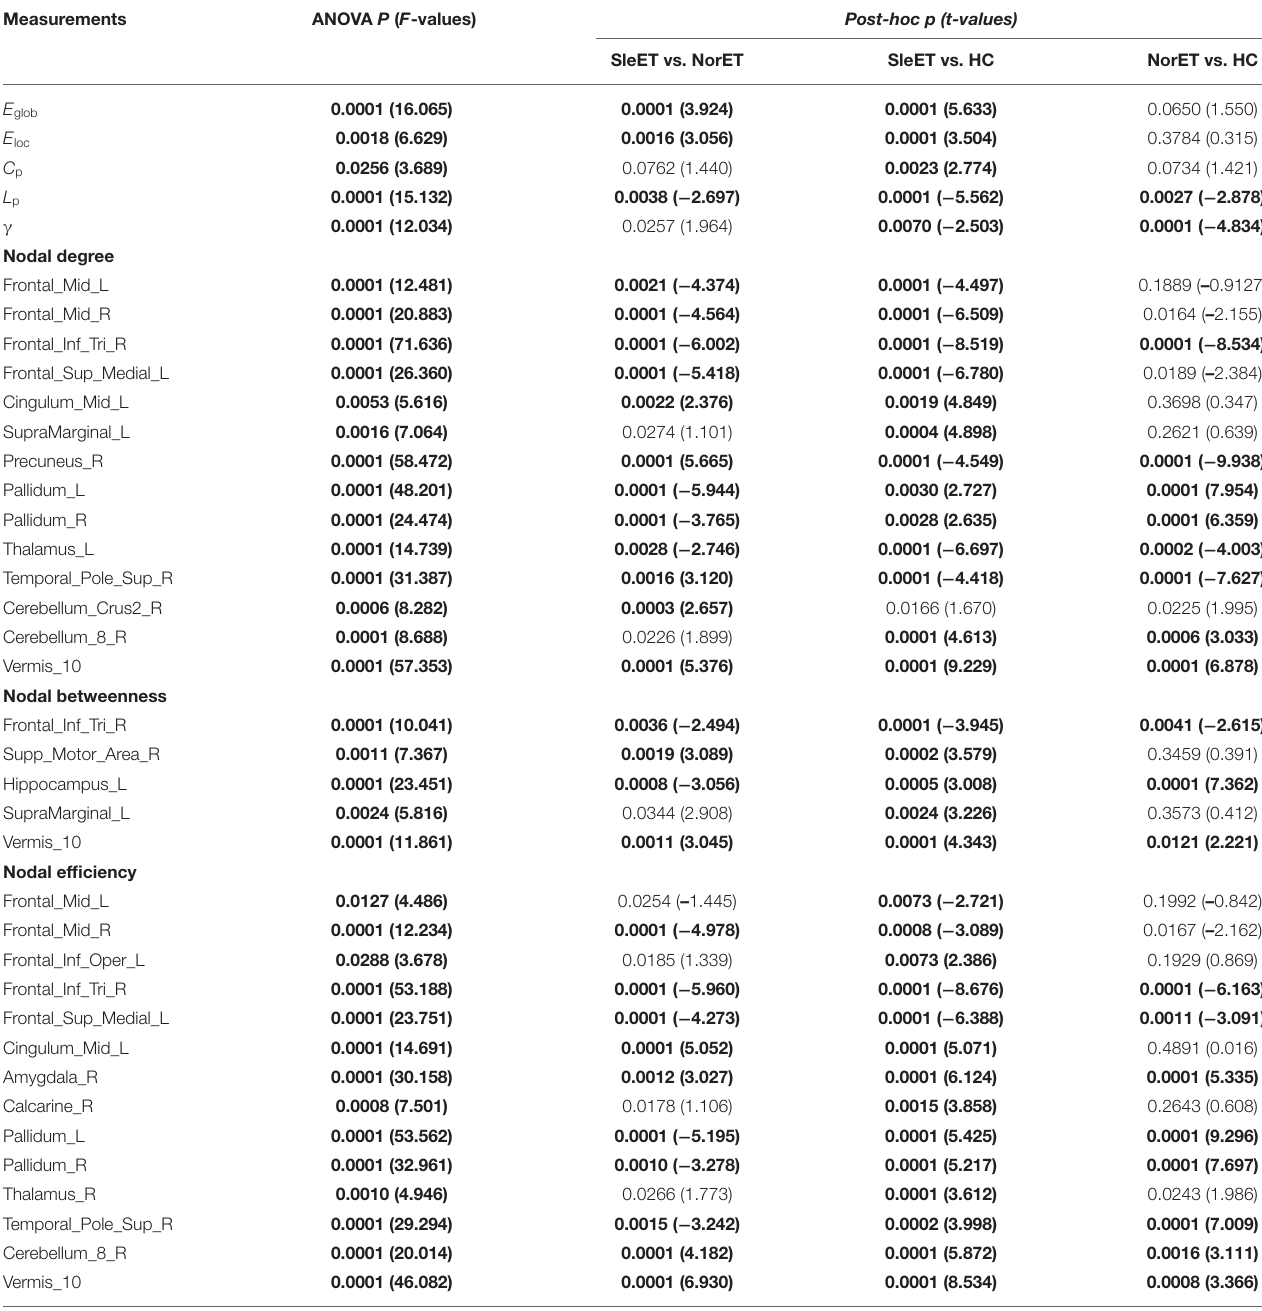
TABLE 2 | Brain topological metrics showing differences among the SleET and NorET patient groups and HCs.